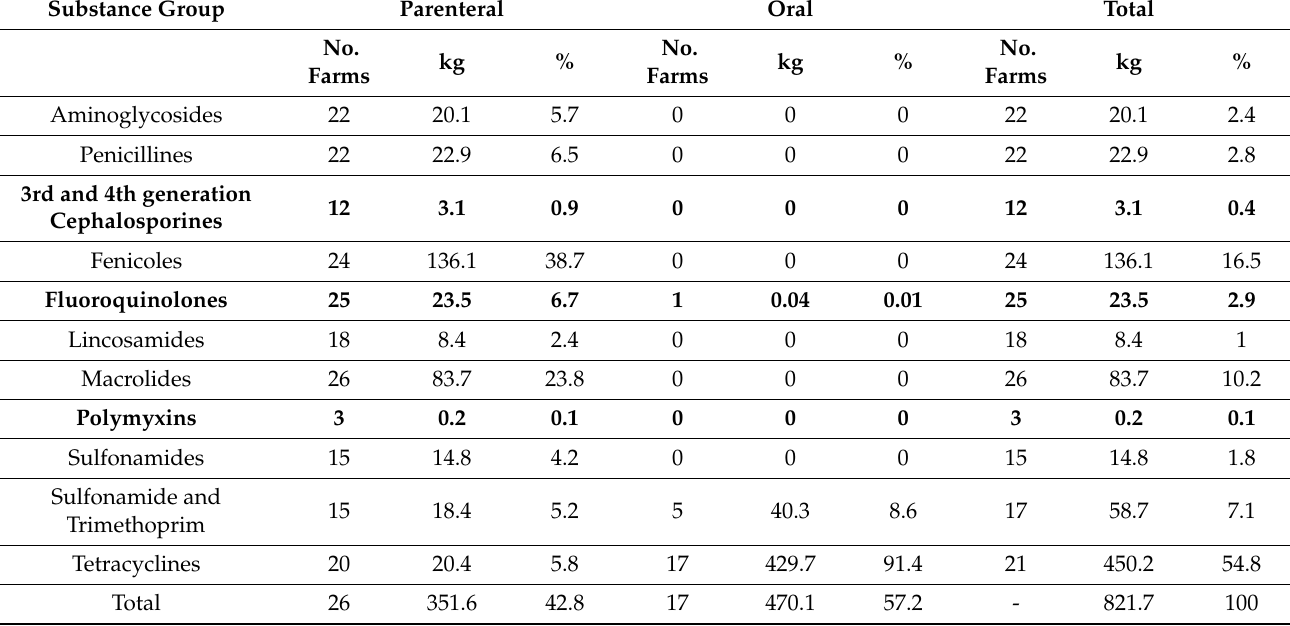
Table 3. Consumption of active substance (kg) by drug group and route of administration (oral and parenteral) from 26 fattening operations located in northwestern Italy, for the years 2014 and 2015. In bold are the highest priority critically important antimicrobials (HPCIA) in category B according to the European Medicine Agency